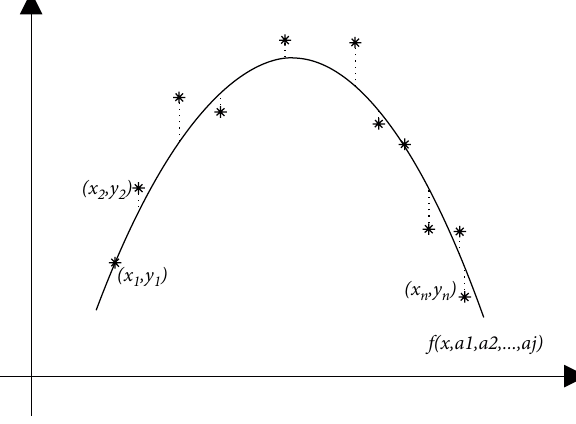
Figure 1: Least square